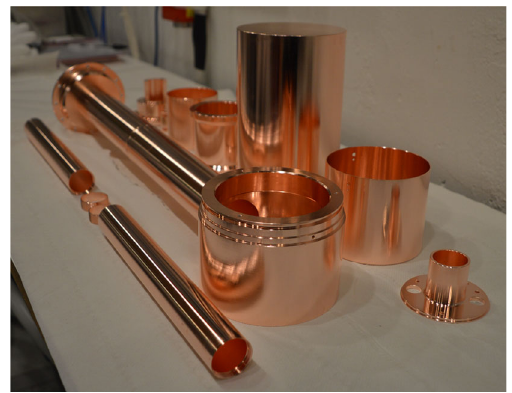
Fig. 5 Electropolished copper cryostat parts used for the construction of the first Conus detector C1 has a demonstrated very reliable mean-time-to-failure